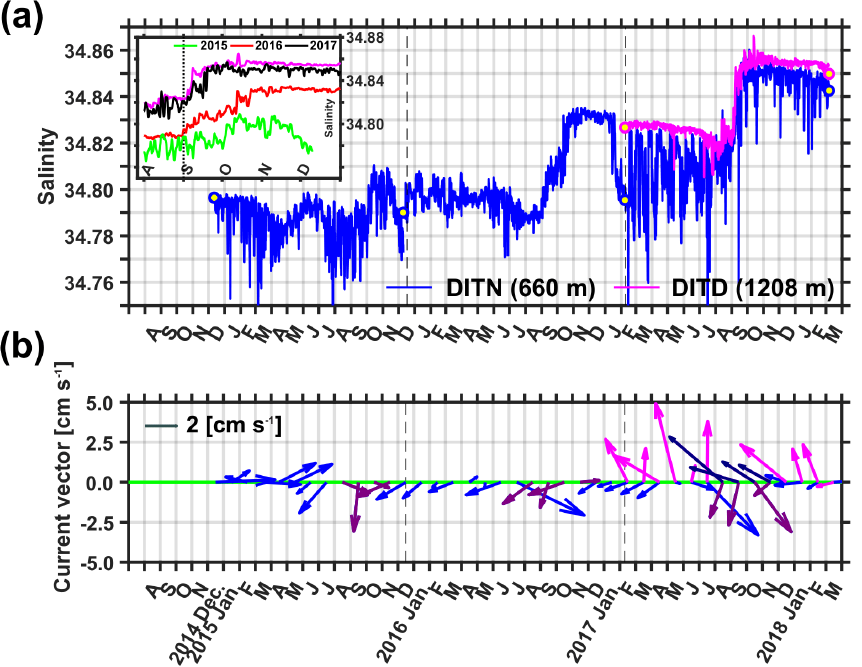
Figure 4. (a) Time series of the near-bed salinity observed in the DITN (blue) and DITD (magenta) from December 2014 to March 2018. The blue (magenta) circles filled with yellow indicate the averaged salinity in a 5m layer at the bottom obtained using CTD data collected near the DITN (DITD). The black dashed line divides periods of each leg in the moorings (see details in Table 1). A zoomed-in plot for the 1d moving average near-bed salinity time series from August to December of each year is shown in the small upper left inset. The magenta time series in the inset is also for the DITD. (b) Monthly mean current vectors at 660m in the DITN and 1222m in the DITD are indicated by blue and magenta arrows. Mean current vectors from August to November in the DITN and DITD are emphasized using purple and navy arrows,